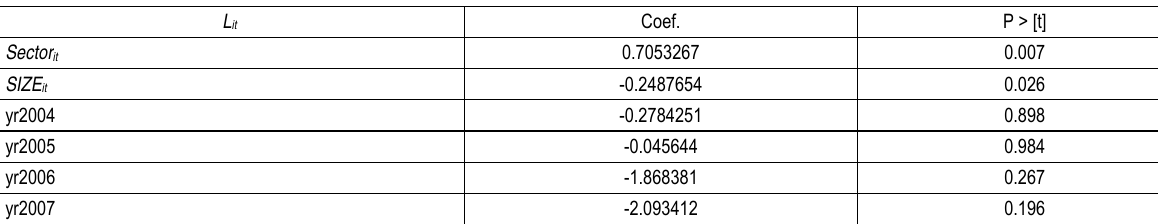
Table 5. Regression results, Model